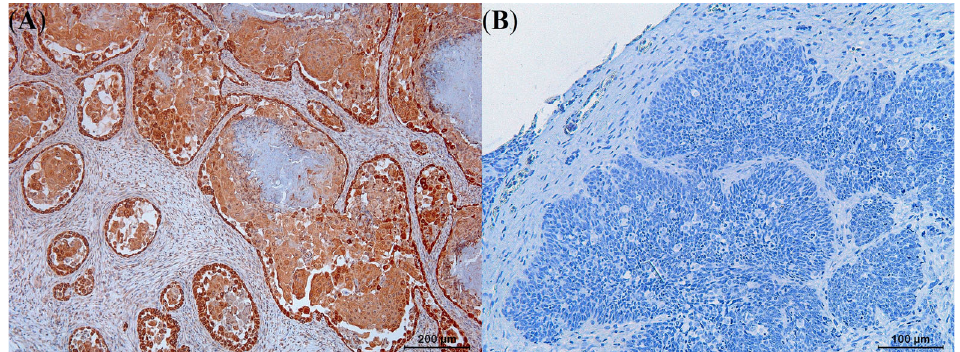
Figure 10. Diffuse and strongly positive intracytoplasmic cyclooxygenase-2 expression could be noted in a well-differentiated squamous cell carcinoma ( A ) in contrast to negative cyclooxygenase-2 expression in a solid basal cell carcinoma ( B ).